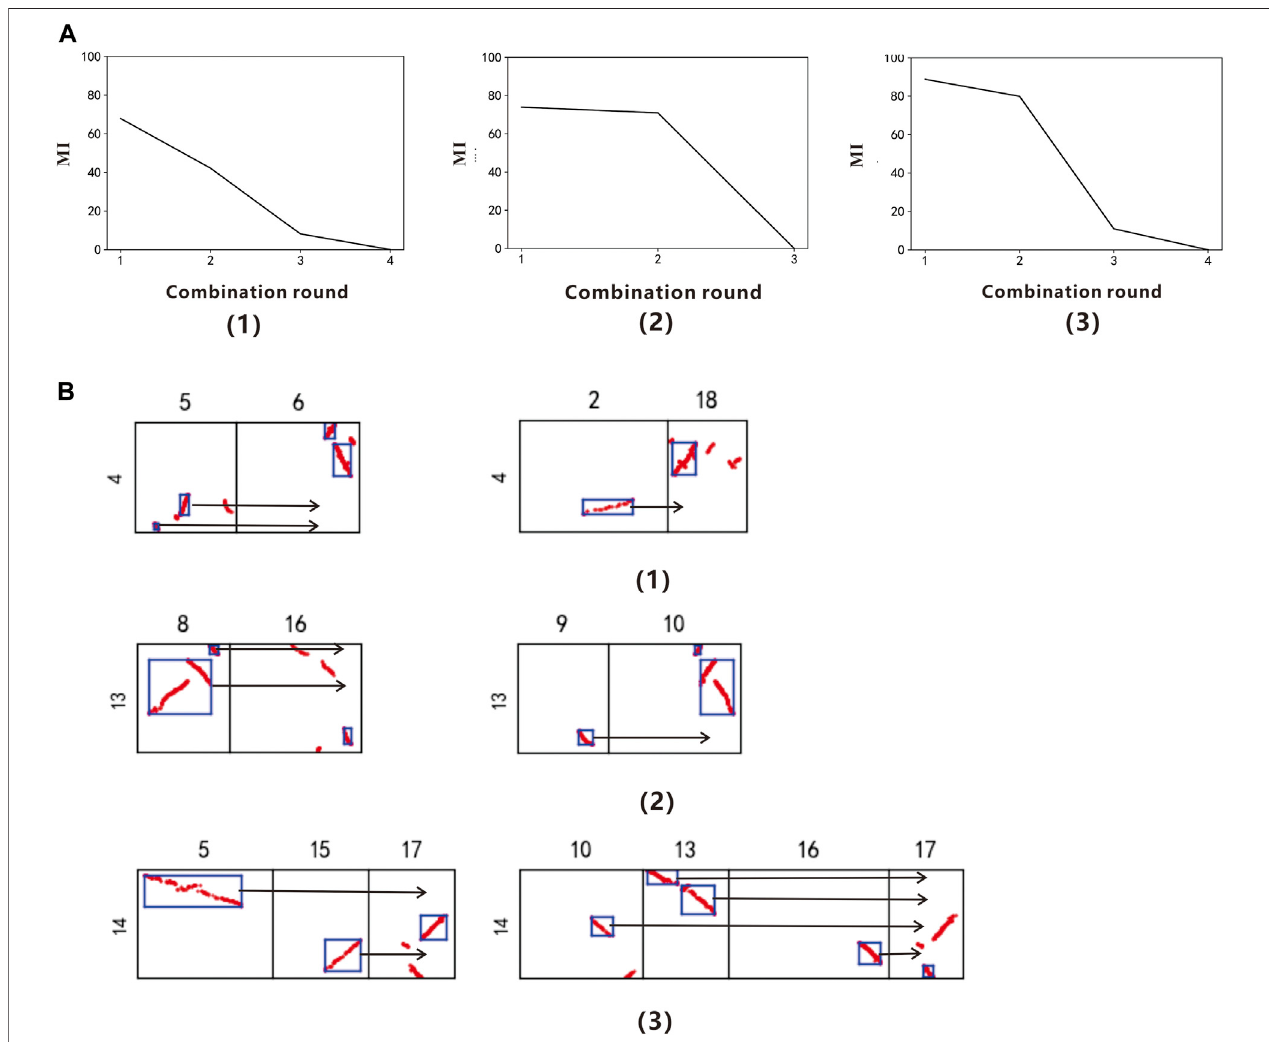
FIGURE 2 | (A) Collinearity evaluation index line chart of Vitis vinifera Chr.4, Chr.13, and Chr.14 (B) Combination fi gure of Salix sinopurpurea polyploidy. (A,B) correspond to each other. (1) The grape chromosome 4 (2) The grape chromosome 13 (3) The grape chromosome